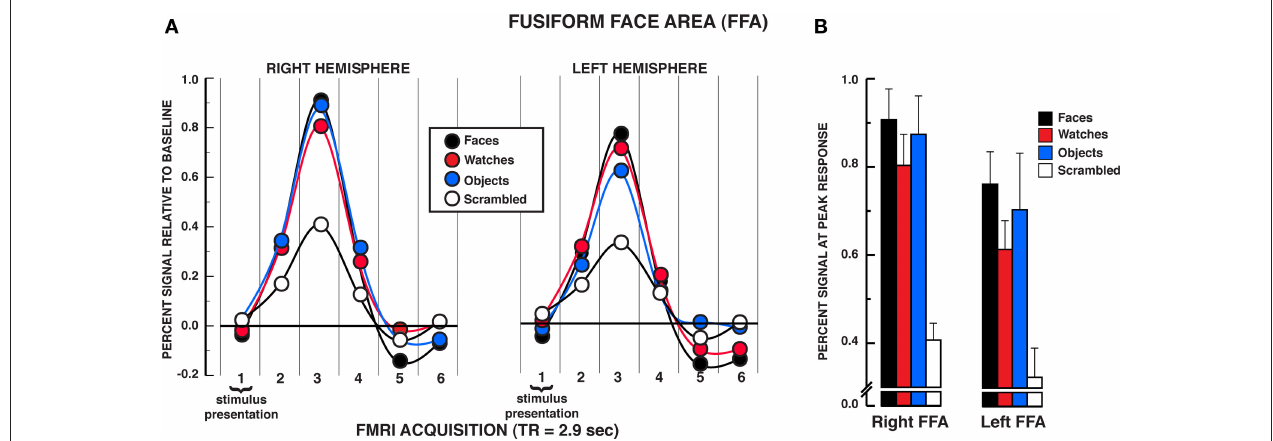
window from the beginning of the trial. With slice-time resampling to the middle of the acquisition period, the peak HRF occurred in the third acquisition for each stimulus type in each ROI that translates to the peak response occurring at approximately 7.25 s post-trial onset. The HRF is shown with a spline interpolation for display purposes. (B) Mean peak response (third HRF acquisition volume) for the four stimuli in the FFA regions of interest. In both the rFFA and lFFA, no statistically significant differences were found between faces, watches, and diverse objects in the rFFA and lFFA. Error bars = SEM.